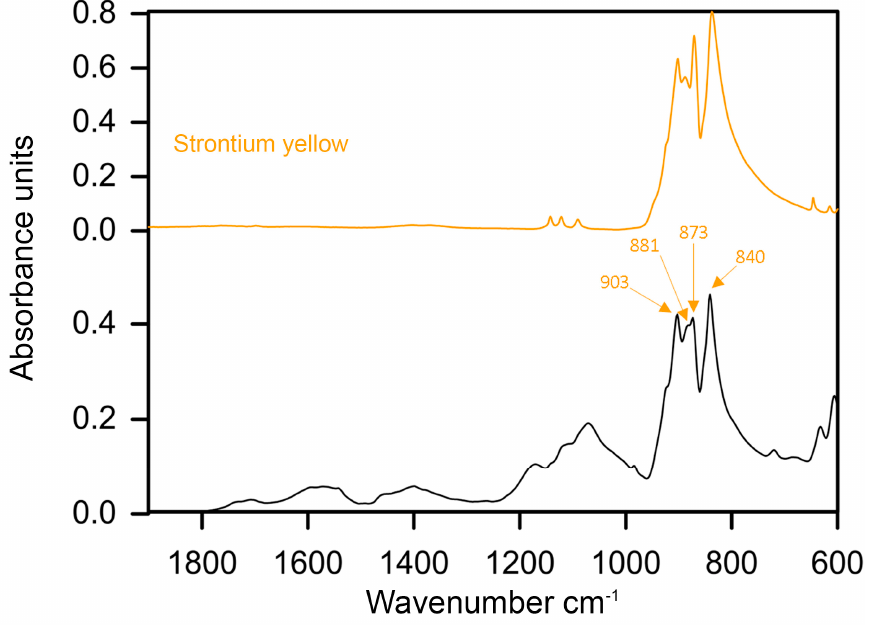
Figure 11. ATR–FTIR spectra obtained from the green paint of sample 10, extracted from Backyard , 1934 with labelled marker peaks of strontium yellow and reference spectra of the same pigment.